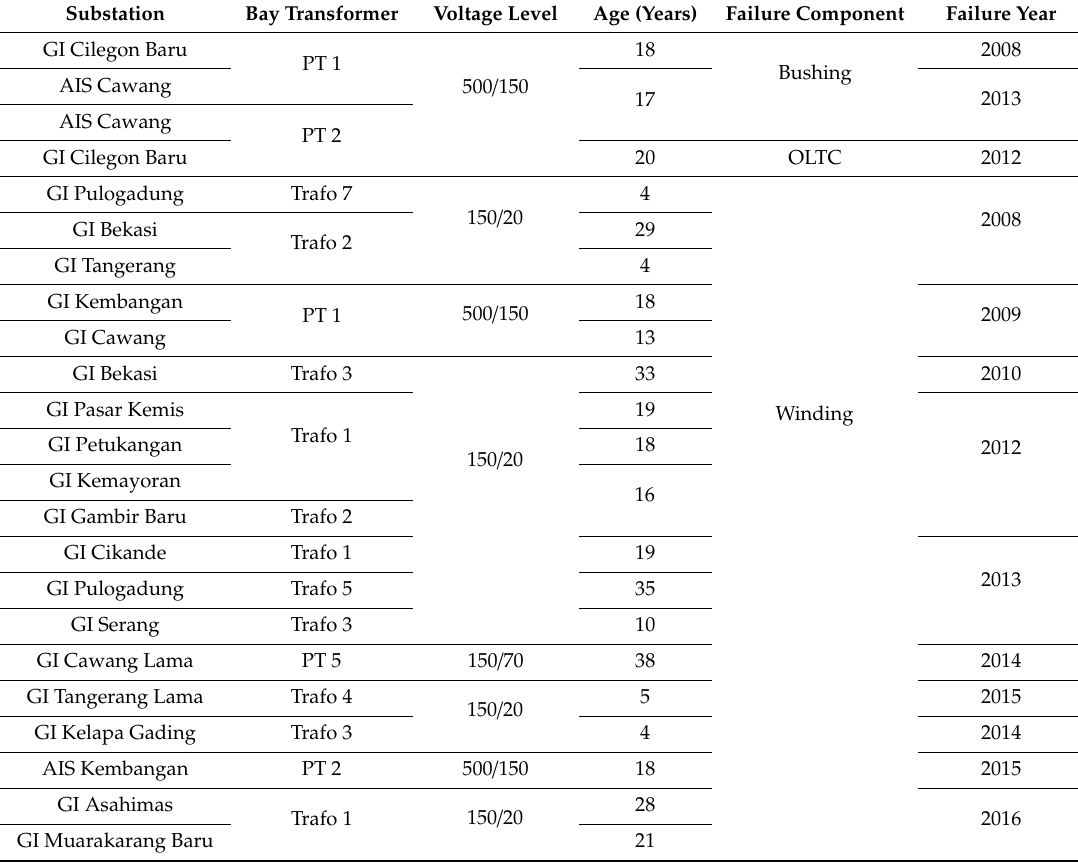
Table 4. Statistical data of PT failures from 2008 and 2016